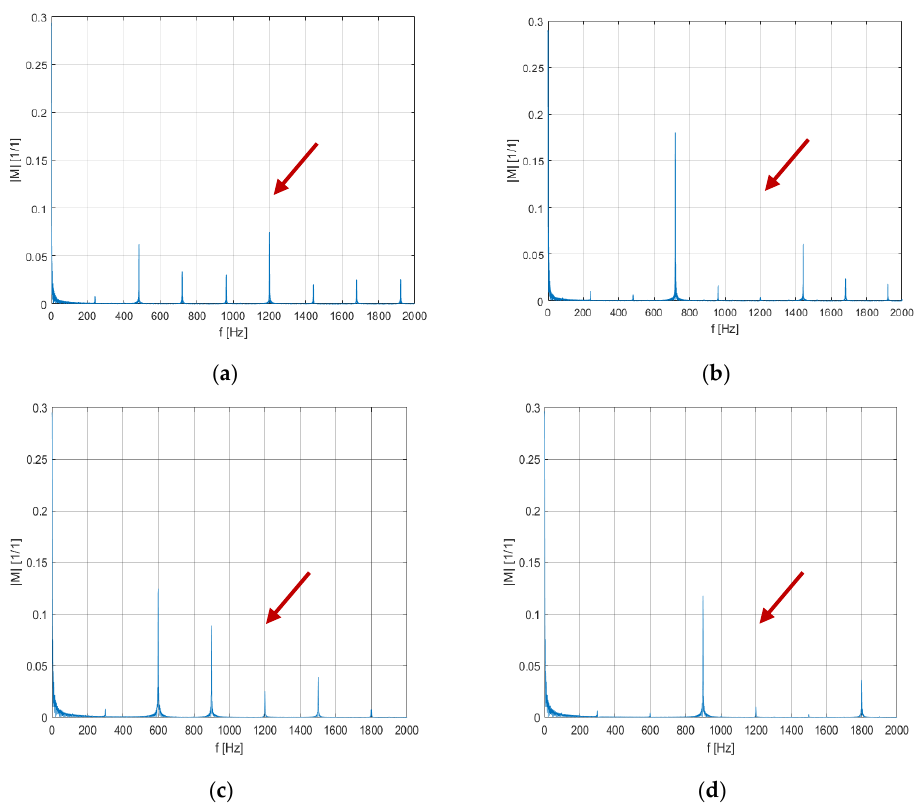
Figure 4. Spectrum of torque harmonics relative values. ( a , c ) 40 and 50 Hz, respectively, for the SCPWM method; ( b , d ) 40 and 50 Hz, respectively, for the SHE method.